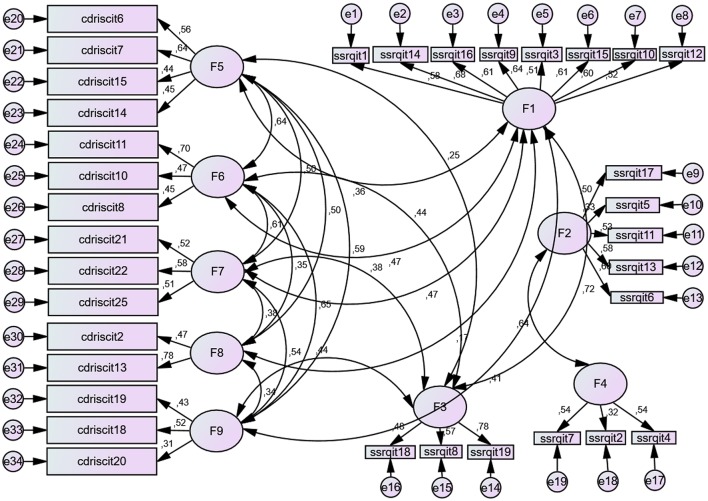
Association relations between resilience and self-regulation factors. Self-regulation: F1, Goals; F2, Perseverance; F3, Learning from mistakes; F4, Decision making. Resilience: F5, Coping and confidence; F6, Tenacity and adaptation; F7, Perception of control and achievement; F8, Perception of support; F9, Tolerance of Negative Situations. For the items, see Annexes I and II in Supplementary Meterial.